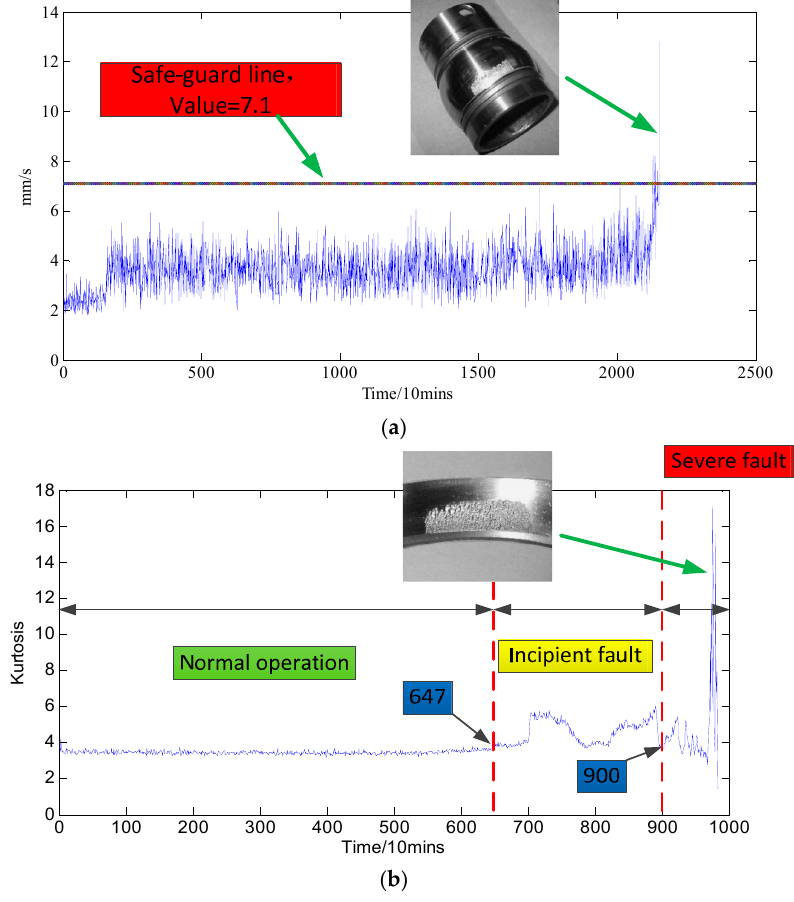
Figure 4. The equivalent vibration intensity (EVI) curve and kurtosis curve of the bearing degeneration. ( a ) EVI curve of rolling bearing 3; ( b ) kurtosis curve of rolling bearing 1.